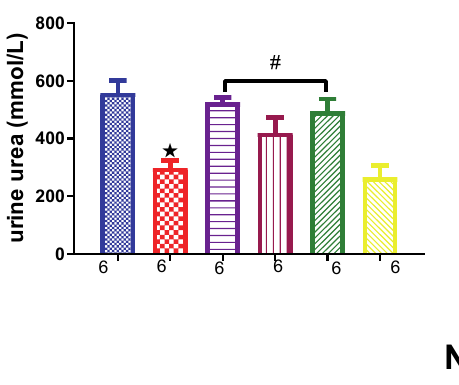
Figure 16. ( A , B ) Urinary and plasma urea concentrations in normal control (NC), prediabetic control (PD), metformin and diet intervention (MET + DI), metformin and high-fat/high-carbohydrate diet (MET + HFHC), rhenium (V) compound and diet intervention (Re + DI) and rhenium (V) compound and high-fat/high-carbohydrate diet (Re + HFHC) groups after 12 weeks of treatment. Values are presented as means ± SEM (n = 6). (cid:70) p < 0.05 in comparison with NC; # p < 0.05 in comparison with PC, MET + DI, MET + HFHC, Re + DI and Re + HFHC. Figure 17A,B show urinary and plasma creatinine concentrations in the normal control (NC), prediabetic control (PD), metformin and diet intervention (MET + DI), metformin and high-fat/high-carbohydrate diet (MET + HFHC), rhenium (V) compound and diet intervention (Re + DI) and rhenium (V) compound and high-fat/high-carbohydrate diet (Re + HFHC) groups after 12 weeks of treatment. For plasma creatinine, in comparison with the NC group, the PD group showed a significant increase in plasma creatinine concen- tration ( p < 0.05) (Figure 17A). The administration of the rhenium (V) compound in both the diet intervention and high-fat/high-carbohydrate treatments resulted in a significant de- crease in plasma creatinine concentration when compared with the PD group ( p < 0.05). For urinary creatinine, in comparison with the NC group, the PD group showed a significant decrease in urinary albumin concentration ( p < 0.05) (Figure 17B). The administration of the rhenium (V) compound in both the diet intervention and high-fat/high-carbohydrate treat- ments resulted in a significant increase in urinary creatinine concentration when compared with the PD group ( p < 0.05). A similar effect was observed with the MET + DI-treated group when compared with the PD group ( p < 0.05). See Figure